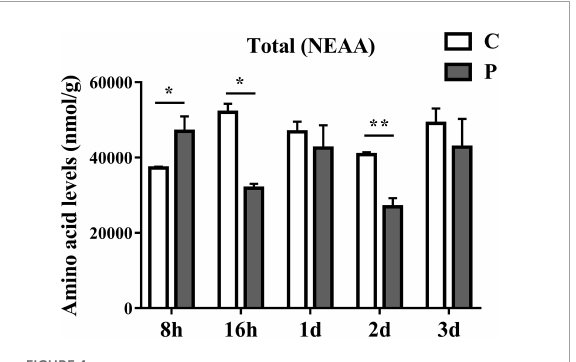
FIGURE4 Parasitism causes changes in the content of total NEAA (Non-Essential Amino Acids) in cotton aphid. C, Non-parasitized cotton aphids; P, Parasitized cotton aphids. Statistical significance (Student’s t -test): * P < 0.05; ** P < 0.01; *** P < 0.001.